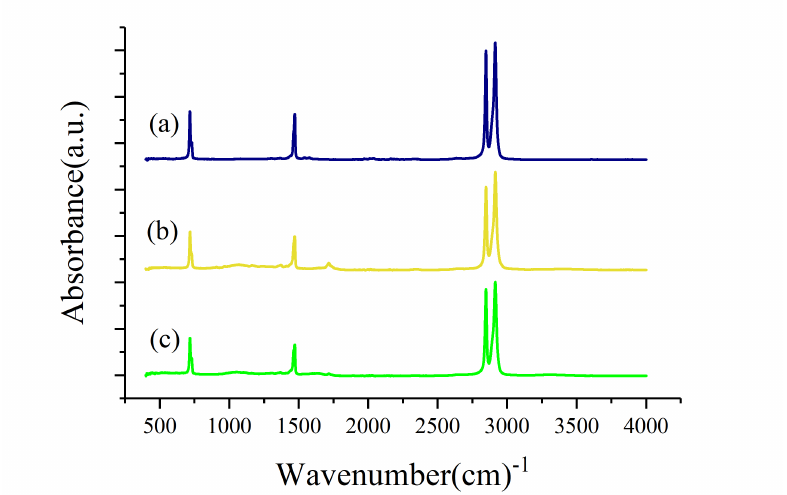
Figure 17. ( a ) UHMWPE powder. ( b ) Coating according to mode-1. ( c ) Coating according to